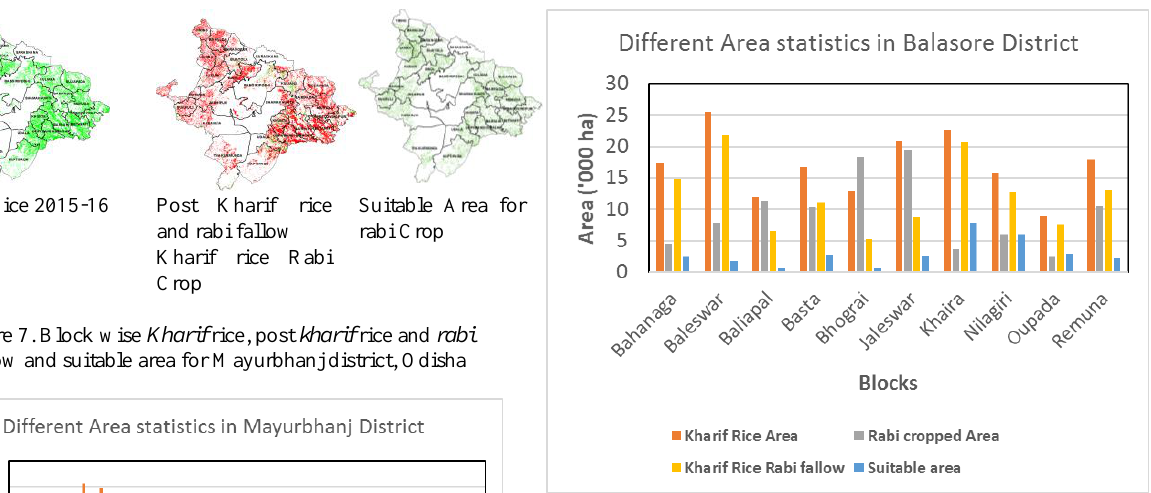
Figure 10. Block level Statistics of Balasore district of